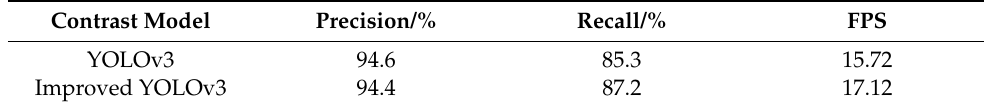
Table 1. Performance comparison results of different detection algorithms.